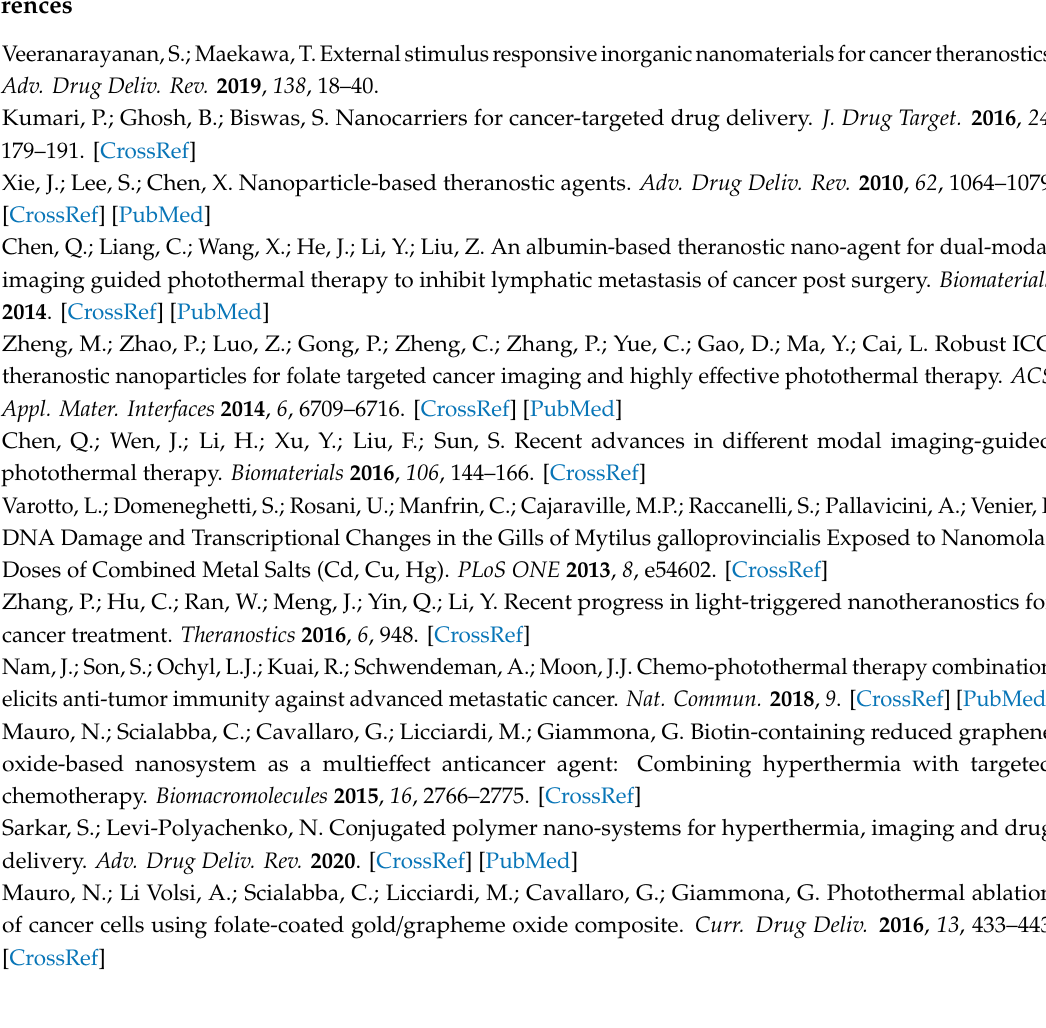
Table S1: Genes and oligonucleotide primers used in this study, Table S2: Statistical analyses by Student’s t -tests of RT-qPCR analyses in MCF7 cell line, Table S3: Statistical analyses by Student’s t -tests of RT-qPCR analyses in MCF7 cell